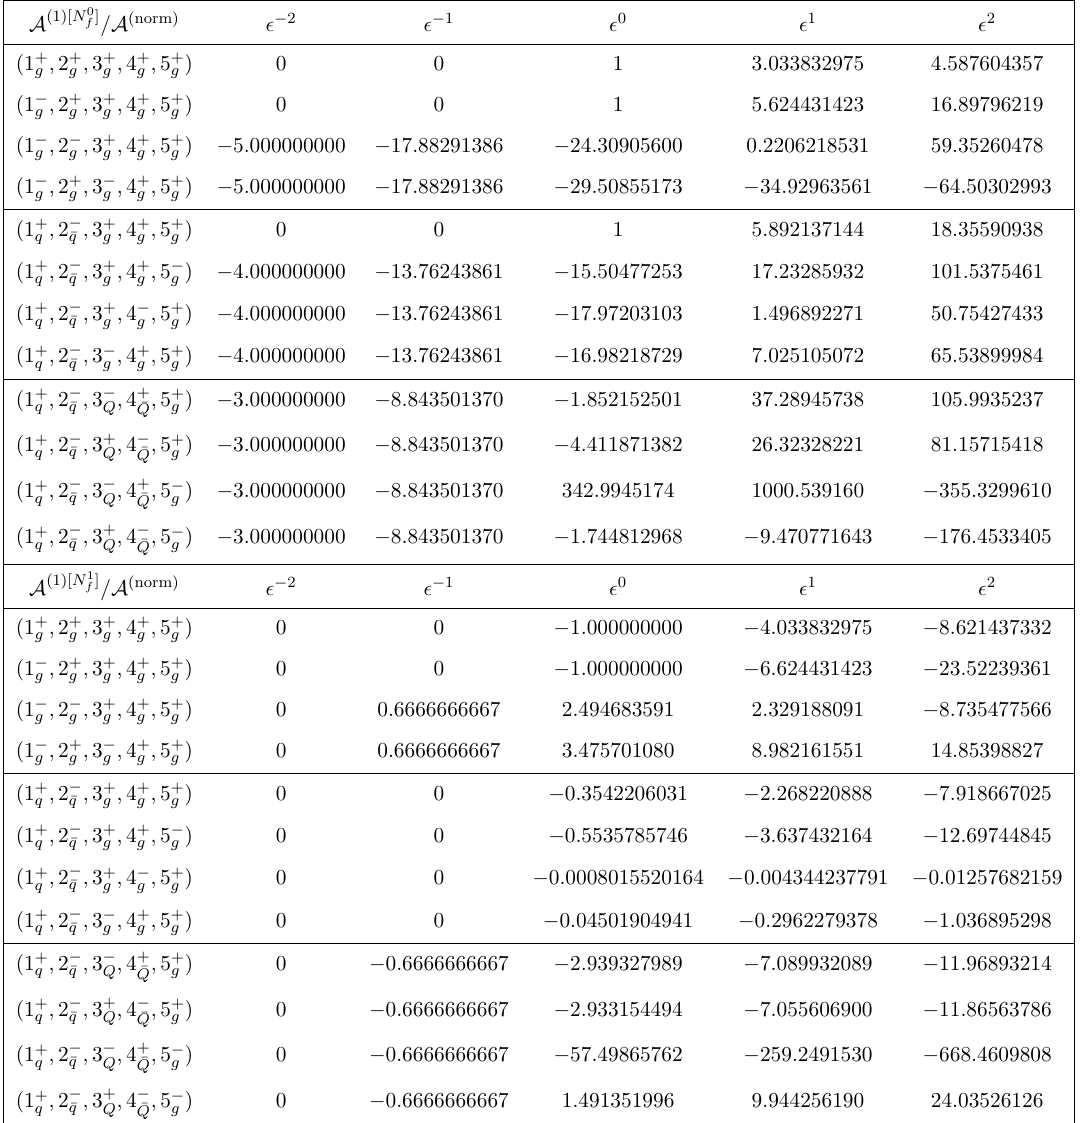
Table 4 . The bare one-loop (cid:12)ve-parton helicity amplitudes evaluated at the phase space point in eq. (4.2). We set the normalization factor A (norm) to A (1)[ N 0 f ] ( (cid:15) = 0) for the amplitudes with vanishing trees, and to A (0)